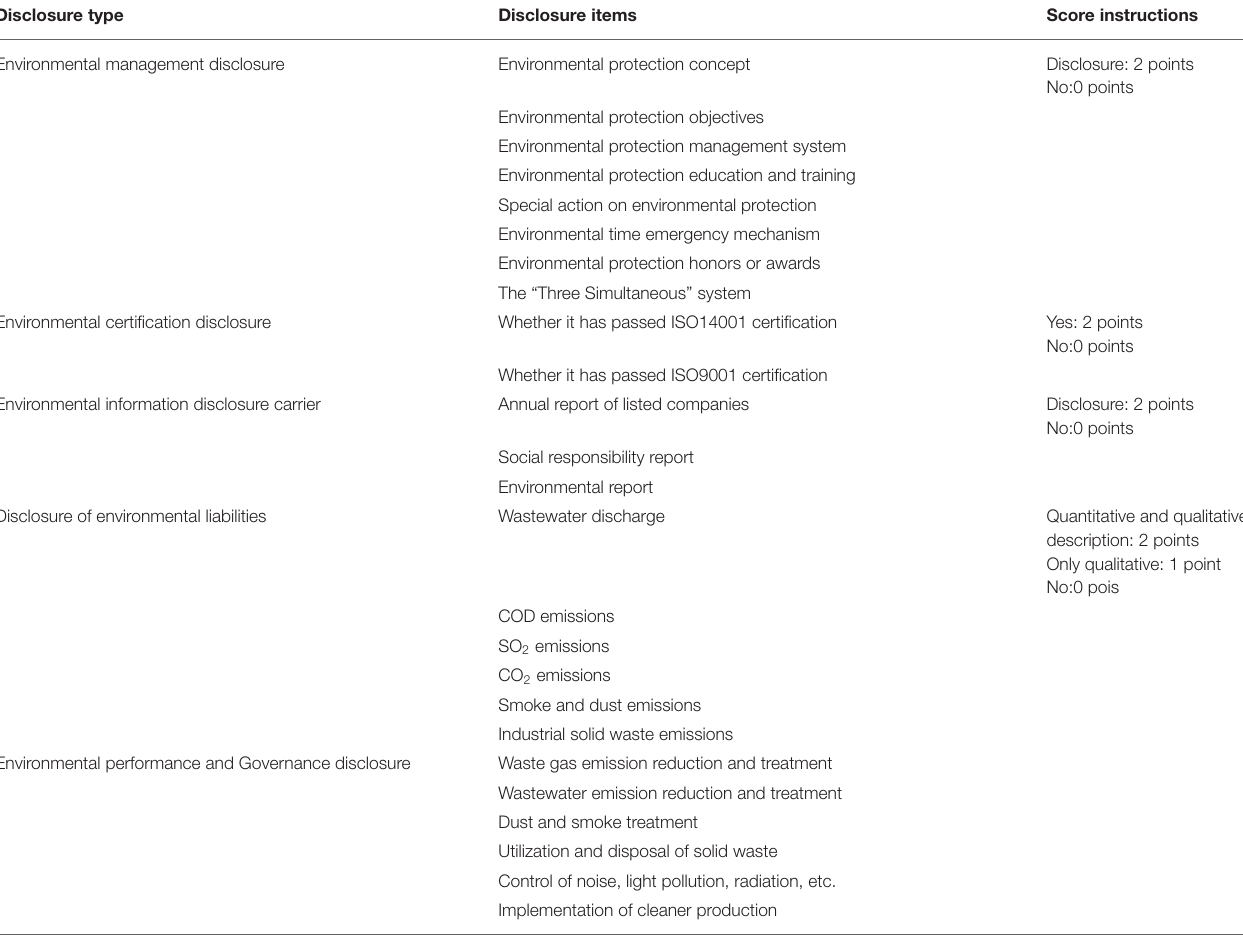
TABLE 1 | Scoring criteria for environmental information disclosure